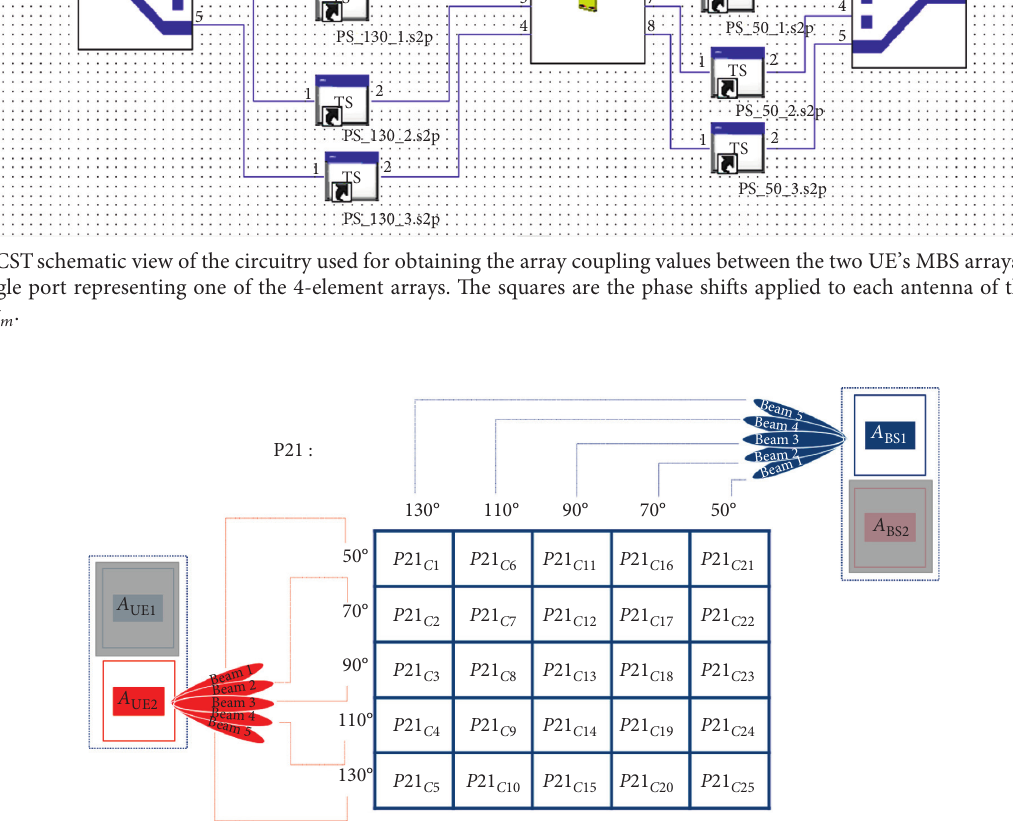
channel for time slot t 21